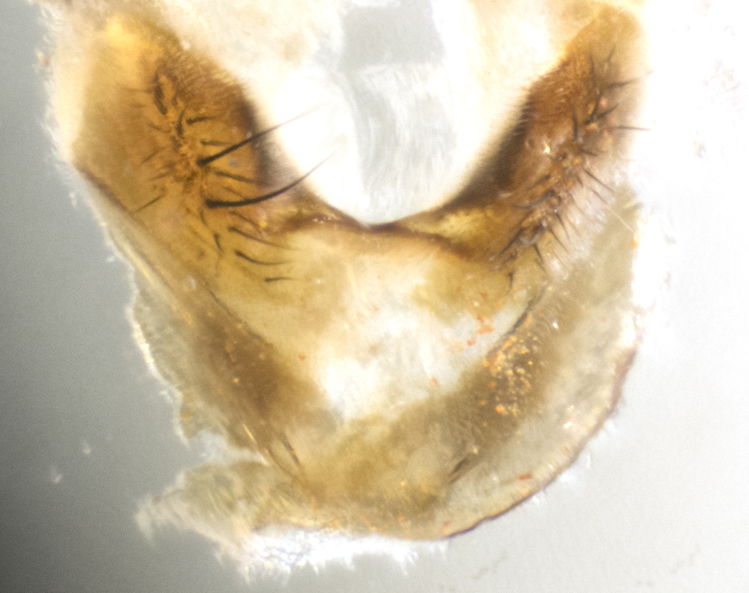
sternite 5, ventral view